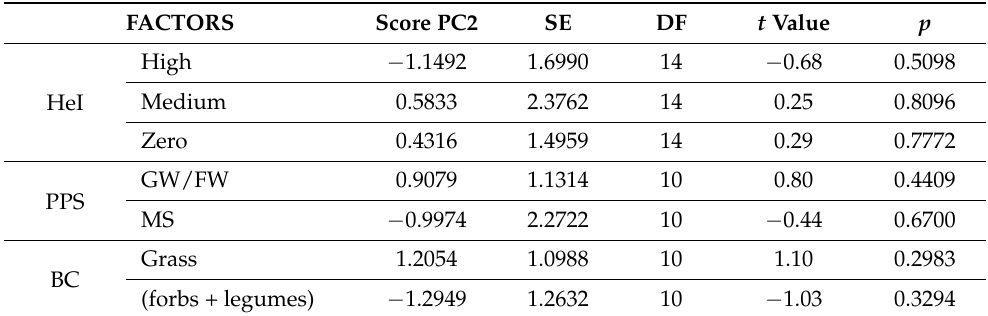
Table 4. p values, standard error (SE) degree freedom (DF), and t value of PC2 estimated score values, performed by a GLM repeated measures procedure for the factors of herbage intake (Hel), plant phenological stage (PPS) and pasture botanical composition